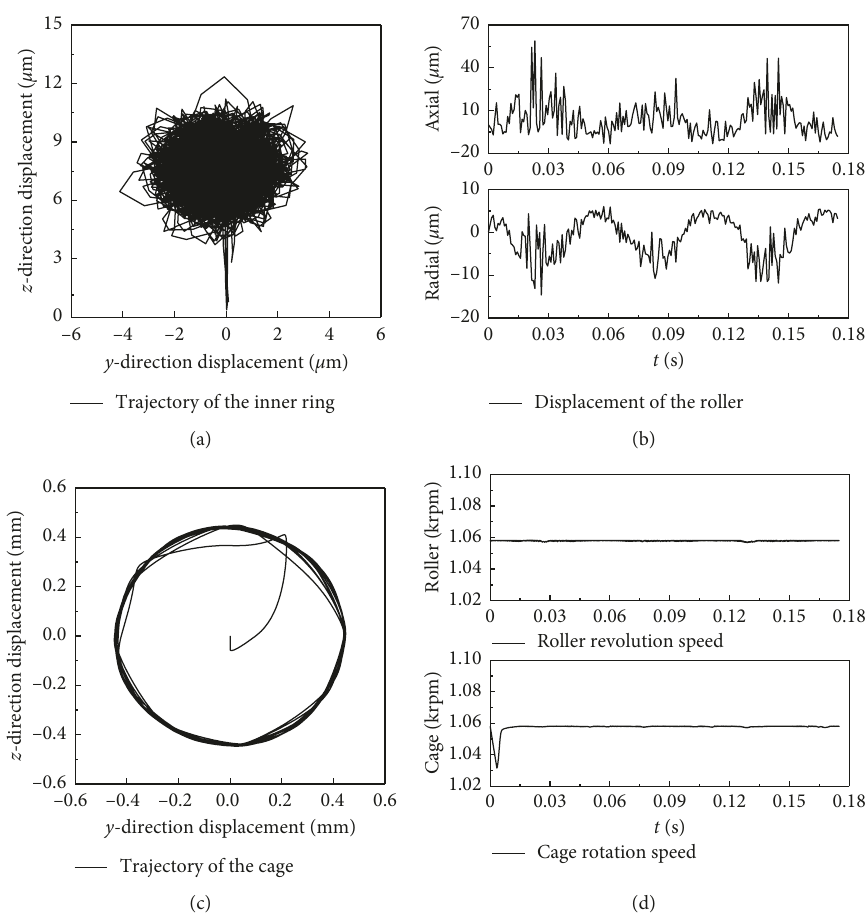
Figure 5: The trajectory and velocity of mass center. F